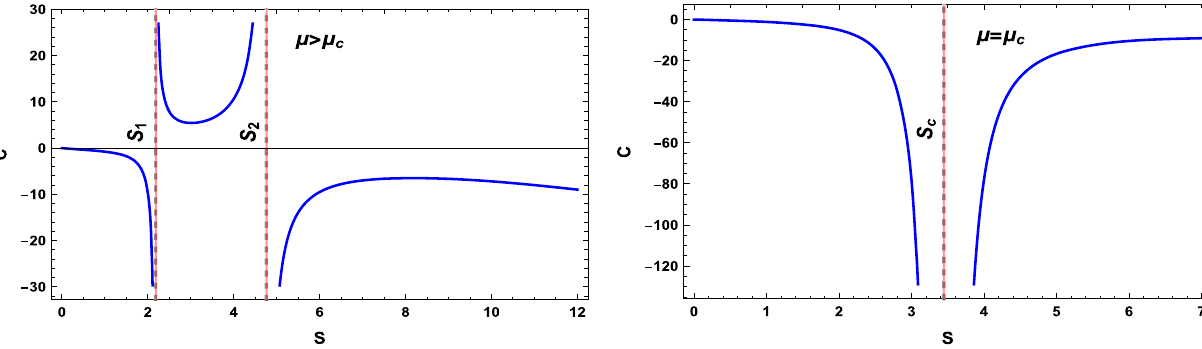
Fig. 8 Grand Canonical ensemble: the heat capacity as a function of S , left panel for μ > μ c and the right panel is for μ = μ c . The dashed lines correspond to the divergency points of C (cid:16),μ , the red lines correspond to critical points. We used the following values: (cid:16) = 0 . 5 , c = 1 , α = 1 and β =